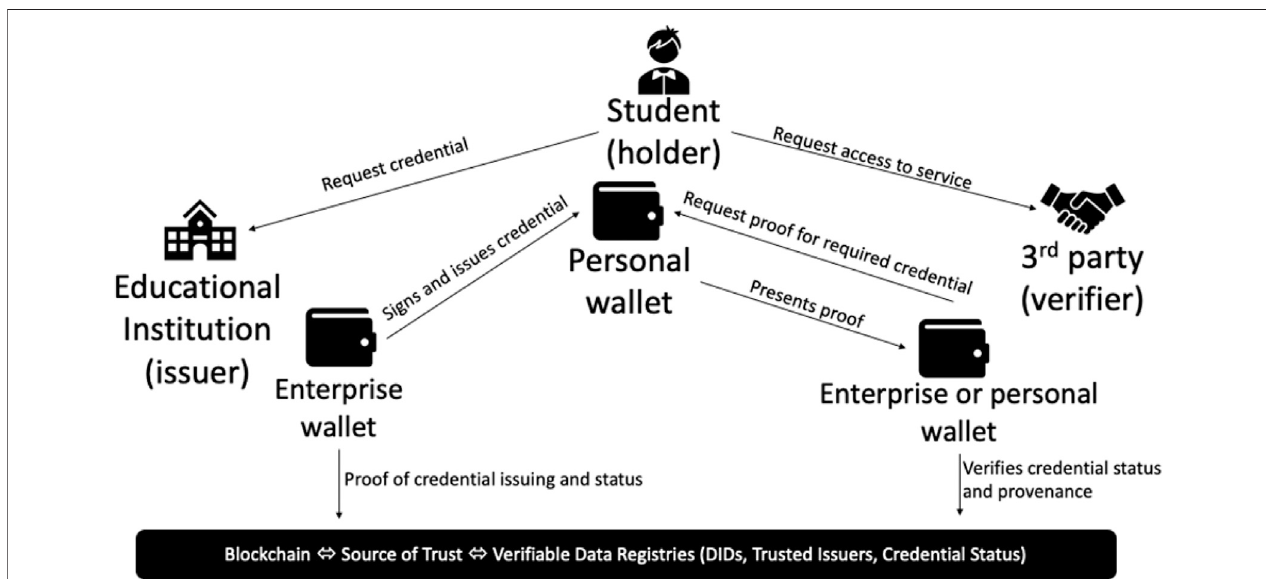
FIGURE 1 | Main components and fl ows for an enabled SSI and Blockchain